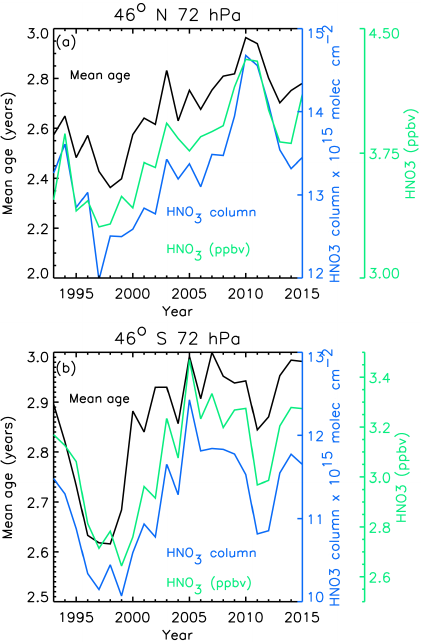
Figure 4. The evolution of the GMI CTM HNO 3 mixing ra- tio (green) and mean age (black) at 72hPa and the HNO 3 col- umn (blue) at (a) 46 ◦ N and (b) 46 ◦ S. The HNO 3 column is N × 10 15 moleculescm − 2 , where N is the right blue axis. The time interval begins in 1993, about 18 months after the eruption of Mt. Pinatubo.